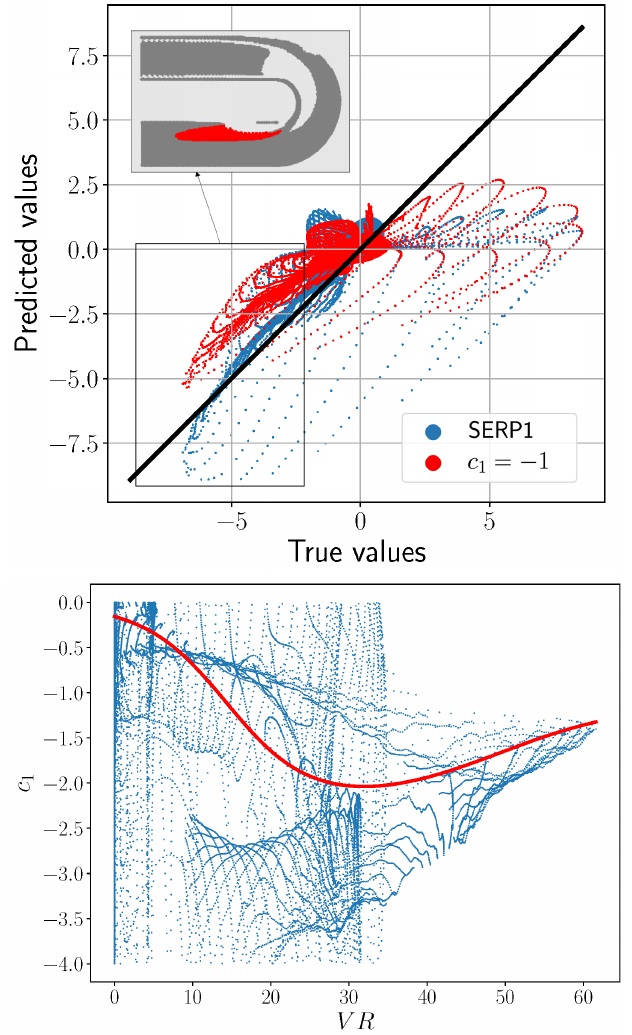
Figure 7. SERP1 a priori assessment: true to predicted τ 12 with comparison to Boussinesq approxi- mation ( top ) and SERP1 best fit of ideal c 1 ( bottom